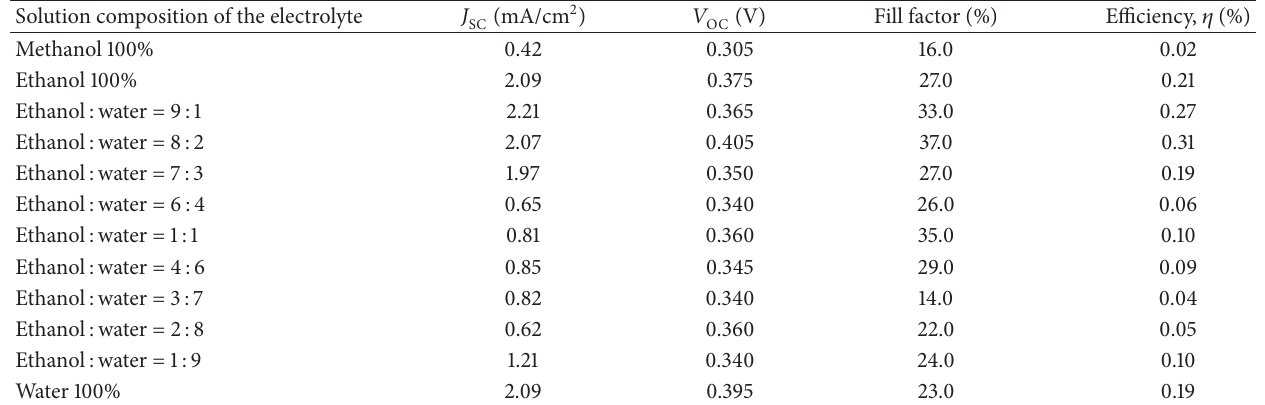
S electrolytes having various solvent ratio. 2